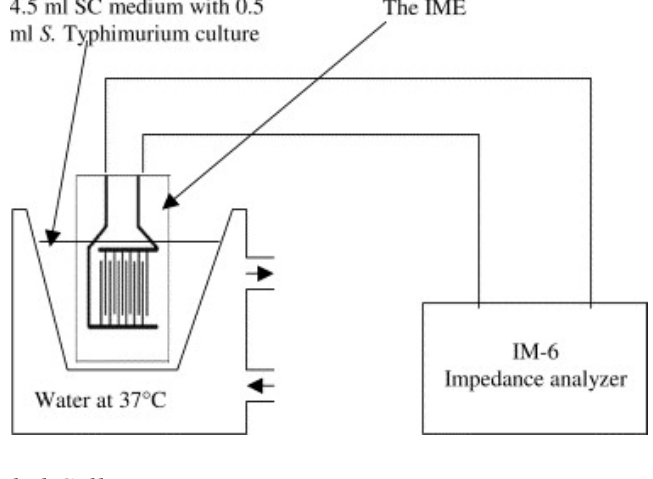
Figure 2. Experimental setup of the impedance measurement with the interdigitated electrodes for the detection of cells. (Copyright 2004. Reprinted from [22] with permission from Elsevier).